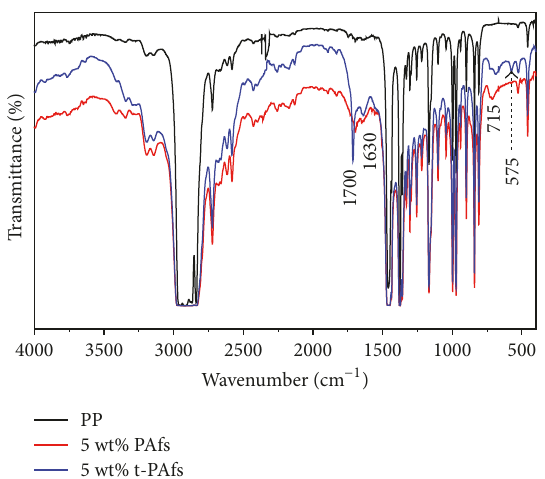
Figure 2: Fourier transform infrared spectroscopy (FTIR) spectra of PP, PP/5wt% PAfs, and PP/5wt% t-PAfs.